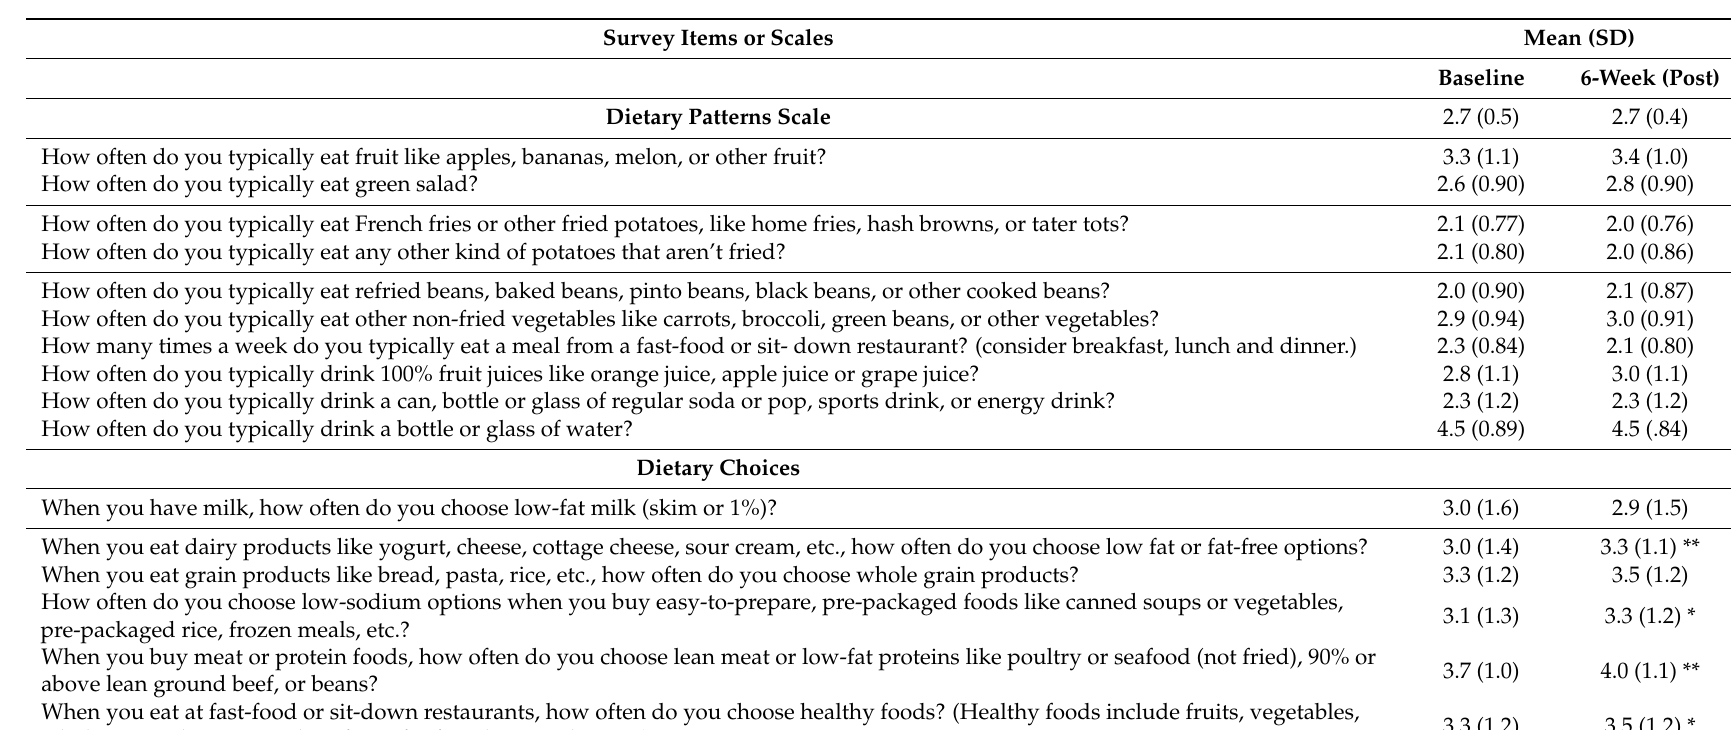
Table 2. Dietary Patterns & Choices Mean